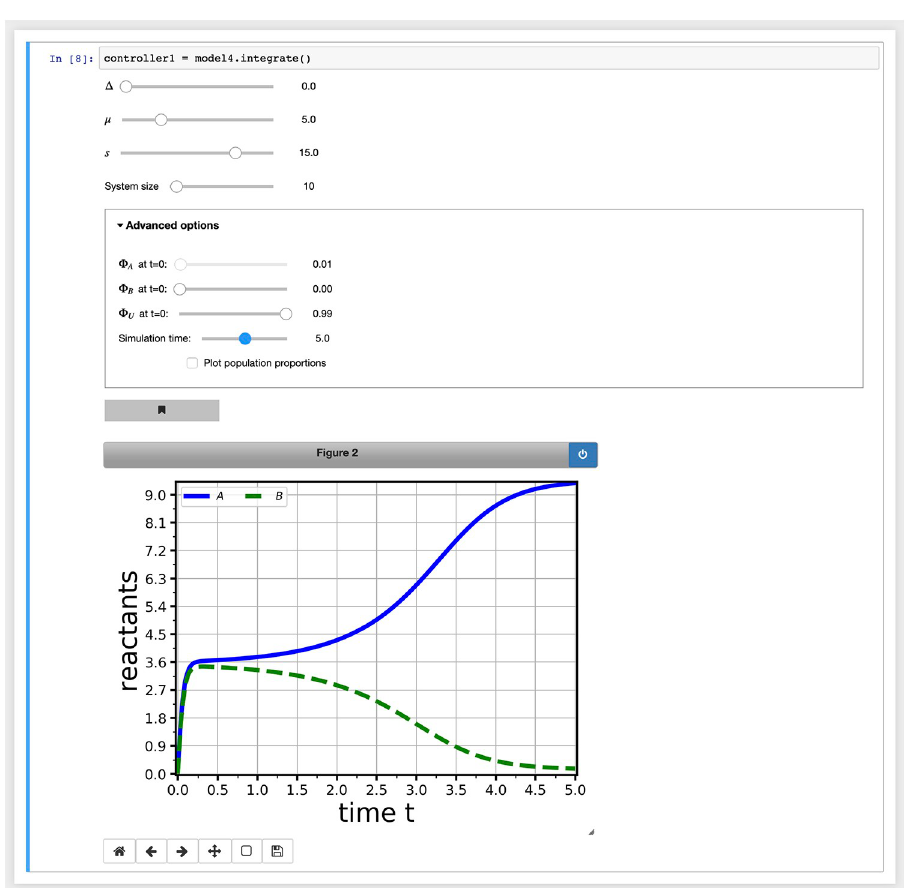
Fig 2. Interactive manipulation of a model view via a controller. Most model analysis commands result in an interactive graphical display of that analysis on the model. Users can explore and visualise the effects of changing free model parameters, and other analysis-specific parameters, through manipulating interactive